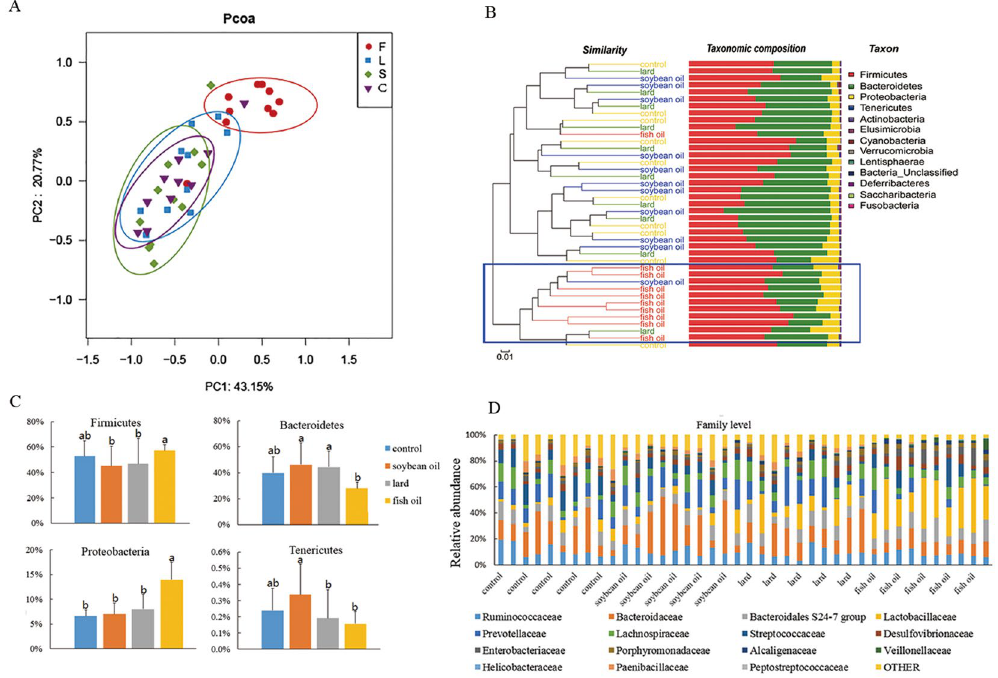
Figure 4. Composition of microbiota in fermentation liquids. ( A ) Principal coordinate analysis of fermentation liquids on the OTU level. F, L, S and C represent fish oil, lard, soybean oil and control groups, respectively. ( B ) Relative abundance of microbial community at the phylum level in fermentation liquids in response to three dietary fats. ( C ) Changes of relative abundance of phyla with significant difference in fermentation liquids. Data were shown as means and standard deviation (bars). The data were analyzed by one-way analysis of variance and means were compared by the procedure of Duncan’s multiple-range comparison. a, b, means with different letters differed significantly (p < 0.05). ( D ) Relative abundance of microbial community in fermentation liquids on the family